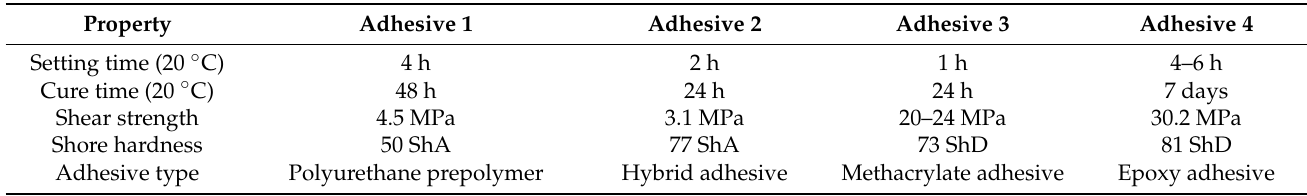
Table 2. Selected properties of adhesives used in